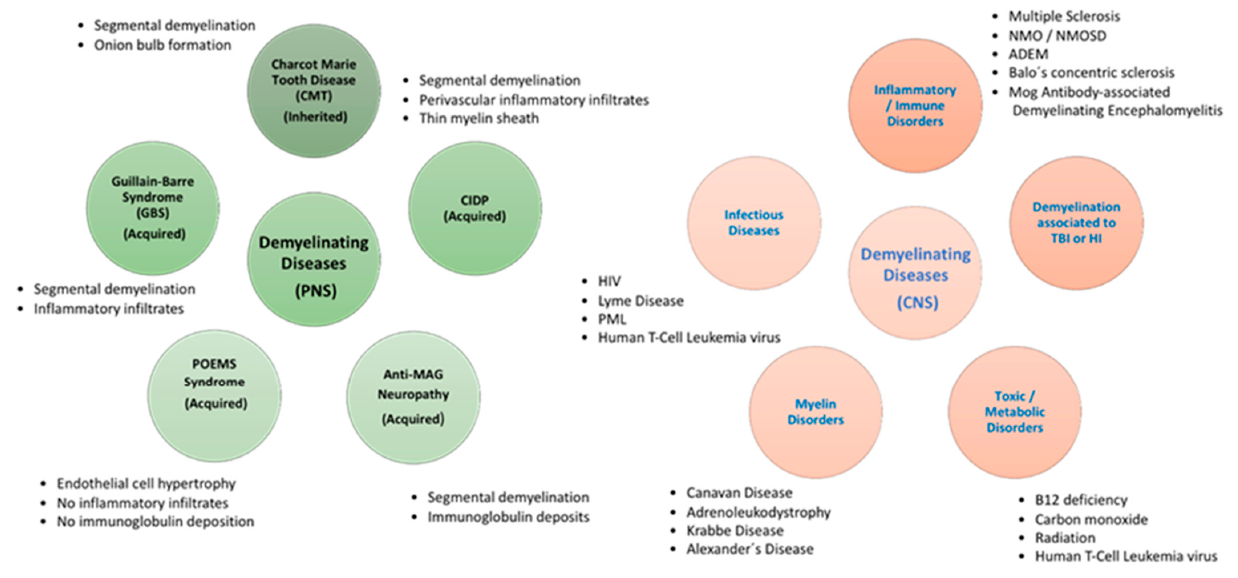
Figure 1. Demyelinating diseases.